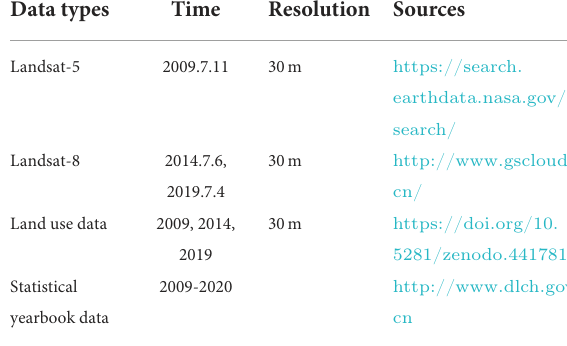
FIGURE2 Tourism incomes and tourism population, 2009–2020.